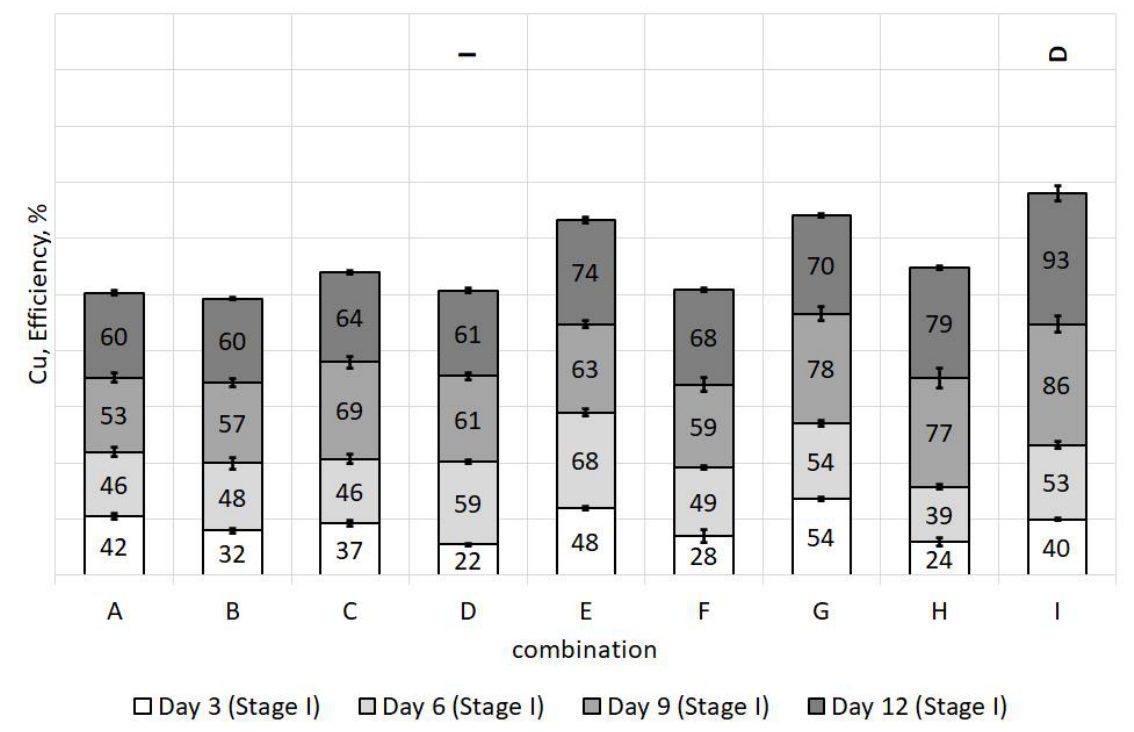
Figure 11. Effectiveness of Cu release to the dissolved fraction of leachate (Stage I).